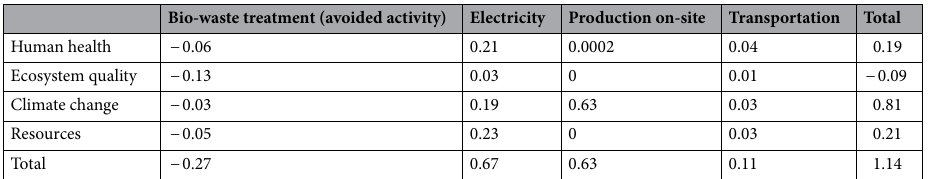
Bio-waste treatment (avoided activity) Electricity Production on-site Transportation Total